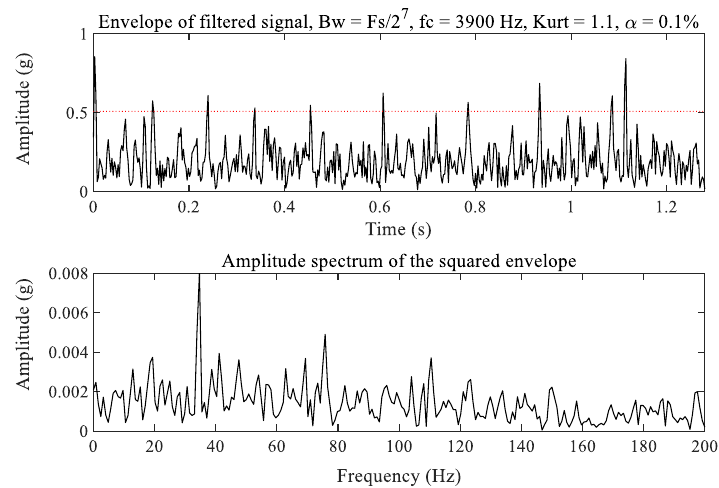
Figure 10. The filtered signal with the optimal carrier frequency 3900 Hz.